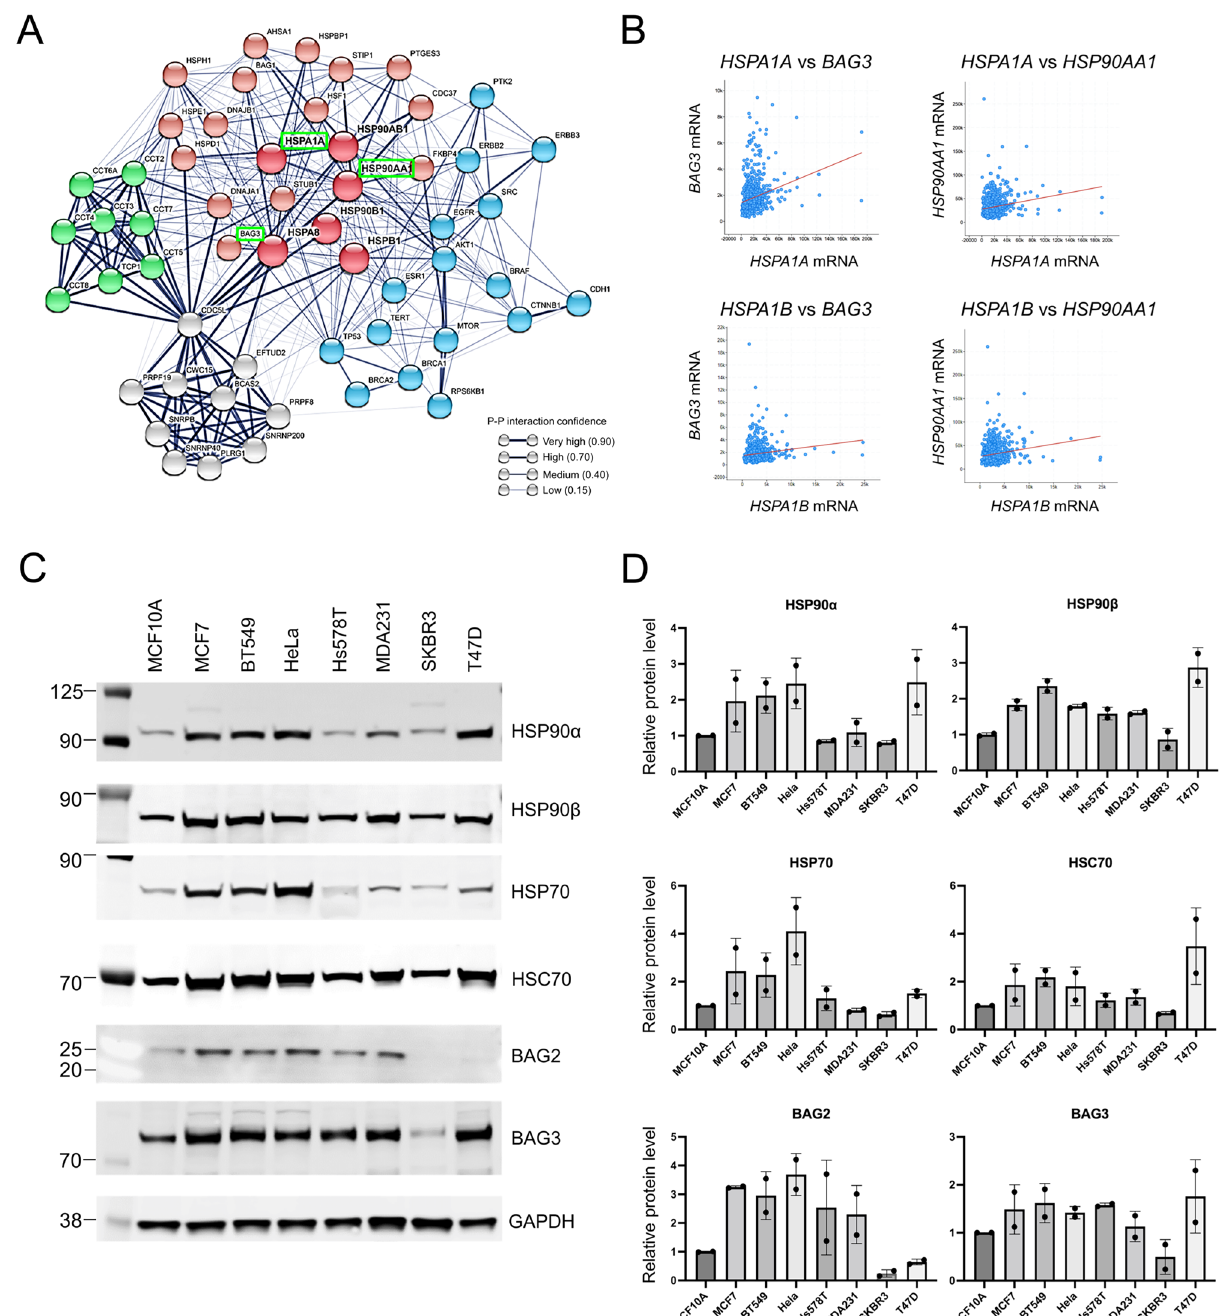
Figure 1. The interaction network of HSPs and co-chaperones in cancer progression. ( A ) Pattern of the gene interaction network of the HSPs, co-chaperone and cancer related genes. Red nodes: HSPs and co-chaperones, blue nodes: cancer-related genes, green nodes: TRiC complex genes, gray nodes: Prp19/CDC5L complex genes. The thickness of the border line indicates the strength of the experimental data supporting a protein–protein interaction. ( B ) Scatter plot analysis showing co-expression correlation between HSPA1A vs BAG3 , HSPA1A vs HSP90AA1 , HSPA1B vs BAG3 , HSPA1B vs HSP90AA1 in patient-derived breast tumor samples (960 cases). ( C ) Western blot analysis of HSP90α, HSP90β, HSP70, HSC70, BAG2, BAG3 and GAPDH in the normal MCF10A human mammary epithelial cell line, cultured human breast cancer cell lines and HeLa cervical adenocarcinoma cells. Original blots are presented in Supplementary Fig. S5. ( D ) Quantitative analyses of western blot for HSP90α, HSP90β, HSP70, HSC70, BAG2, BAG3. GAPDH was used as an internal control. Molecular weight markers are indicated in kilodalton. The data shows mean ± SD obtained in the biological duplicate assay and the individual data points were indicated in a